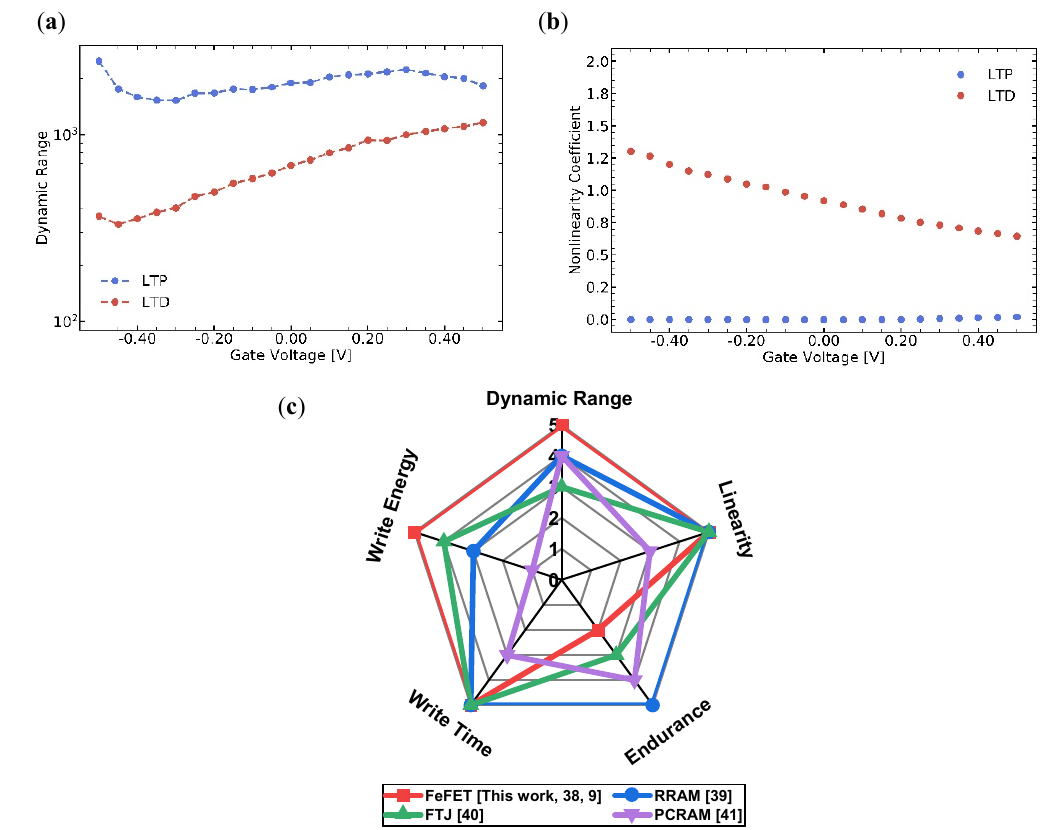
Figure 21. The synaptic LTP and LTD figure of merits as ( a ) the dynamic range and ( b ) nonlinearity coefficients versus the readout voltage; the DR and nonlinearity were extracted from the synaptic LTP/LTD measured using the amplitude-based sequence (Figure 17c for the 200 ns pulse width) on the device dimension (4 µ m × 4 µ m), ( c ) benchmark of the different technology candidates for the synapse performance